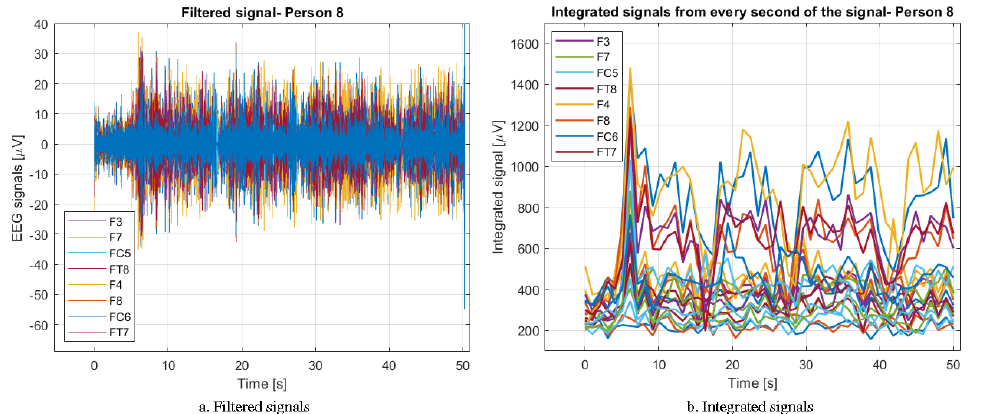
Figure 12. Comparison of filtered and integrated signals—Person 7.